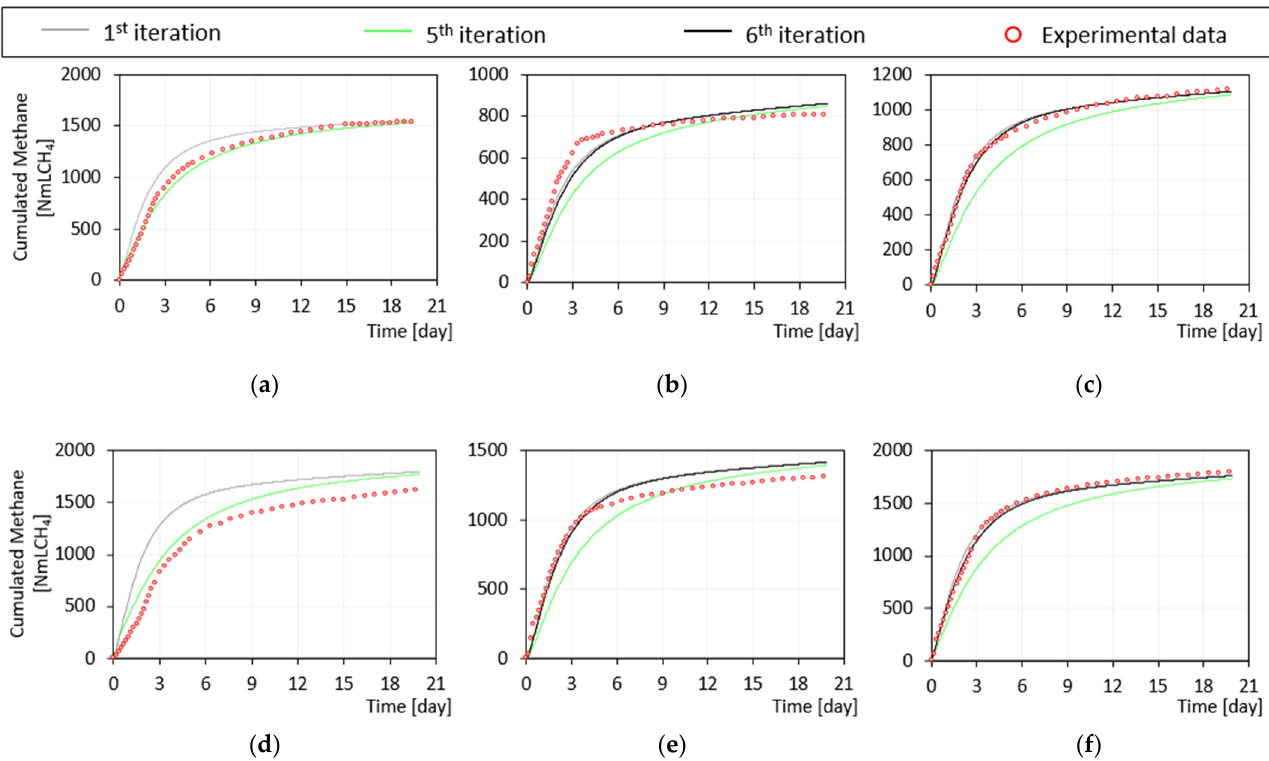
Figure 4. Experimental vs. simulated cumulated CH4 volume in batch activity tests using ( a ) acetate (Phase I), ( b ) glucose (Phase I), and ( c ) BSA (Phase I). The y-axis shows the gross volume of methane produced (NmLCH 4 ).